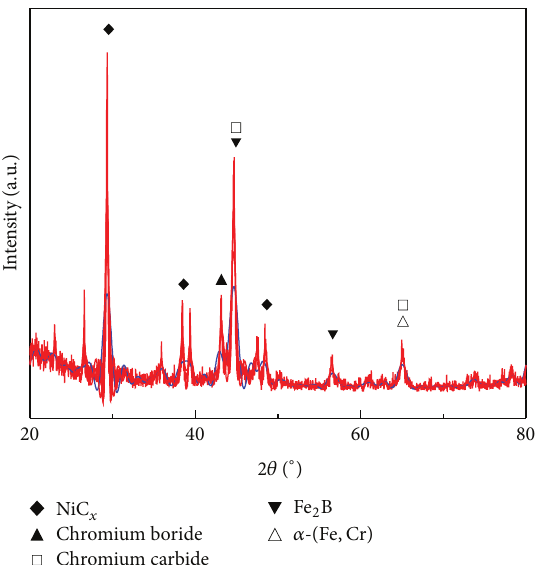
Figure 2: X-ray diffraction pattern of the coating after the plasma remelting. Red line: the original experimental data; blue line: curve fitting.